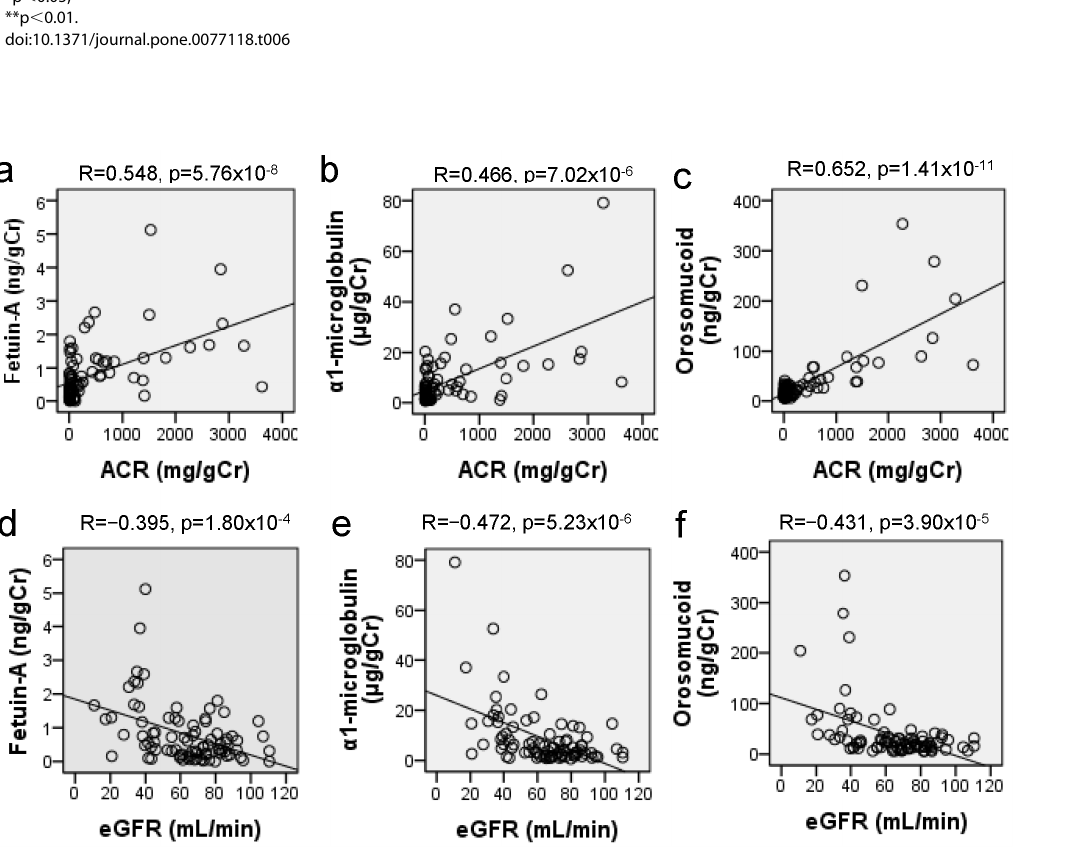
Figure 4. Simple correlation of urinary excretion of fetuin-A, a 1-microglobulin, orosomucoid with estimated glomerular filtration ratio (eGFR) and urinary albumin creatinine ratio (ACR) in the patients with diabetic nephropathy (n=85). Spearman correlation coefficients are used to evaluate whether urinary levels of fetuin-A, a 1-microglobulin, and orosomucoid correlate with eGFR and ACR. doi:10.1371/journal.pone.0077118.g004 PLOS ONE |